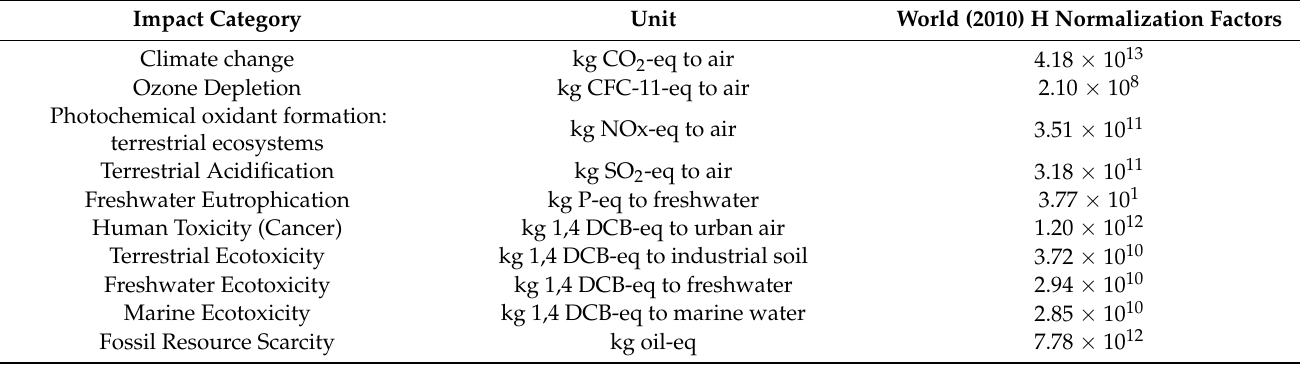
Figure 5. Normalized scores of AAC and PC concrete on midpoint impact categories. Table 6. Normalization factors for midpoint impact categories.